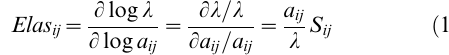
Figure S1 Transition matrix for the multi-state sub- model. From the state at t (rows) to state at t z 1 (columns) different transition probabilities could encompass the following probabilities: annual survival ( s ), radio signal retention during the first three, the fourth and the fifth or more year of life ( a 1 , a 2 , and a 3 , respectively), and mortality due to poisoning given that an animal has died during its first, second or more than second year of life ( b juv , b 1 y , and b 2 my respectively). State abbreviations are a combination of a prefix referred either to the six age-classes (from ‘juv’, for juveniles, to ‘5my’ for 5 or more year olds) or to the cause of death (‘DP’ for dead by poison, ‘DO’ for dead by other reasons), and a suffix that specifies the presence of a functioning radio (‘.t’ and ‘.nt’ for with and without radio signal, respectively). Figure S2 Observation matrix for the multi-state sub- model. The matrix specifies the probability of each event (in column, coded with numbers from 1 to 16) conditional on each state (rows). Codes from ‘1’ to ‘6’ refer to encounters of individuals alive with a functioning radio and belonging to one of the six age- classes, from juvenile to 5 or more years old birds. Codes from ‘9’ to ‘13’ refer to birds alive and without a functioning radio. Codes ‘7’ and ‘14’ refer to individuals found poisoned with and without a functioning radio respectively, while ‘8’ and ‘15’ code for birds found dead for causes other than poisoning, with and without a functioning radio respectively. Code ‘16’ refers to cases when the radio signal cannot be heard and the animal cannot be seen. p is the probability of encounter of an animal with a functioning radio, c is the probability of encounter of an animal alive without an active radio signal, d 1 is the probability of encounter of an animal dead by poisoning and without an active radio signal, d 2 is the probability of encounter of an animal dead by other causes and without an active radio signal. For state abbreviations see transition matrix in Fig. S1. (TIF) Model Code S1 R and WinBUGS codes including the data to fit the integrated population model. The directories in the code need to be customized.